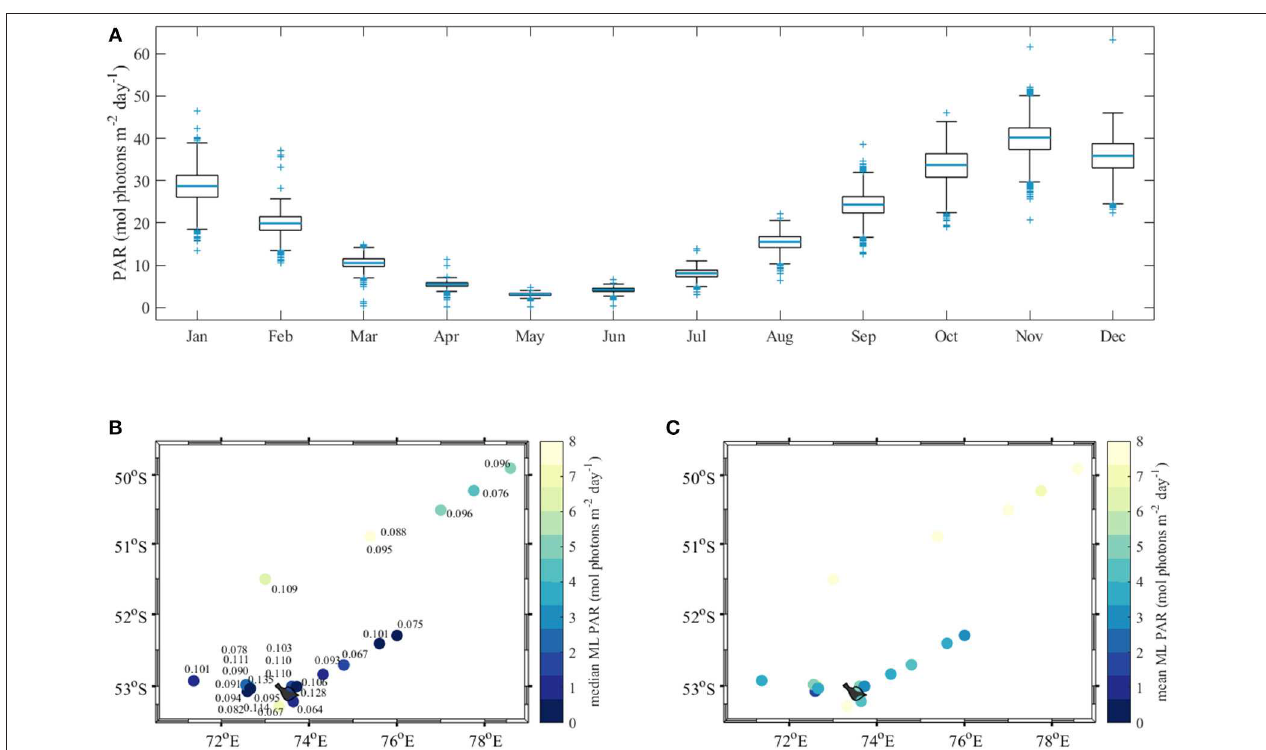
FIGURE 11 | (A) Monthly surface daily PAR dose in the vicinity of Heard and McDonald islands between 2002 and 2017; (B) median and (C) average mixed layer daily doses of PAR. In the boxplot (A) the blue lines indicate the median and the box represents the range between 25 and 75% quartile and the whiskers correspond to ± 2.7 standard deviation (99.3% of data if normally distributed). The numbers in (B) are the K d (PAR) values.